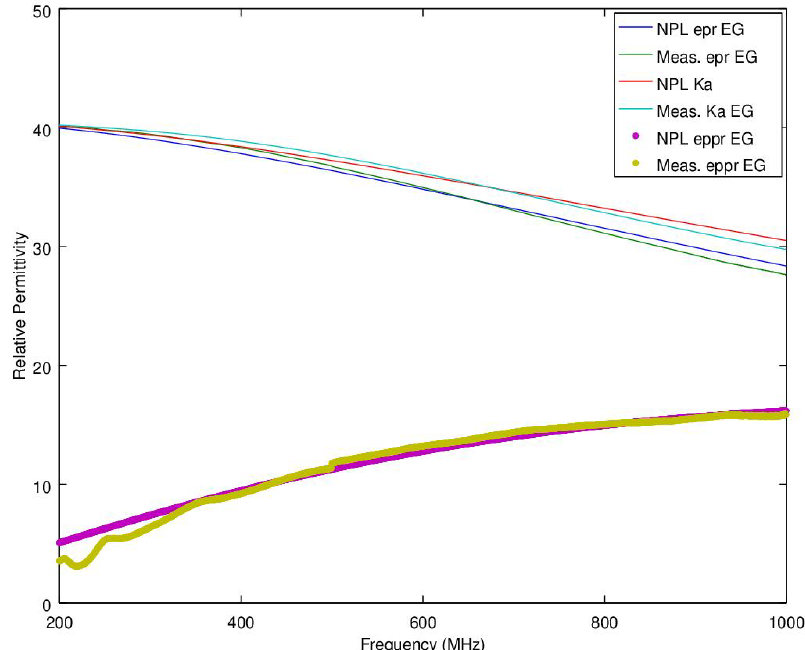
Figure 5. This is a chart of measurement results comparing experimental results against published results from National Physics Laboratories (NPL) in UK (ethylene glycol (EG, also known as ethanediol)). These results suggest that this probe design has highest accuracy above 300 MHz. Of importance is the effect of the loss which manifests as a deviation between the NPL dielectric constant and common low ‐ loss approximation Ka, especially at high frequencies. Legend: epr (relative dielectric constant, ε′ ); eppr (relative dielectric loss, ε″ ).